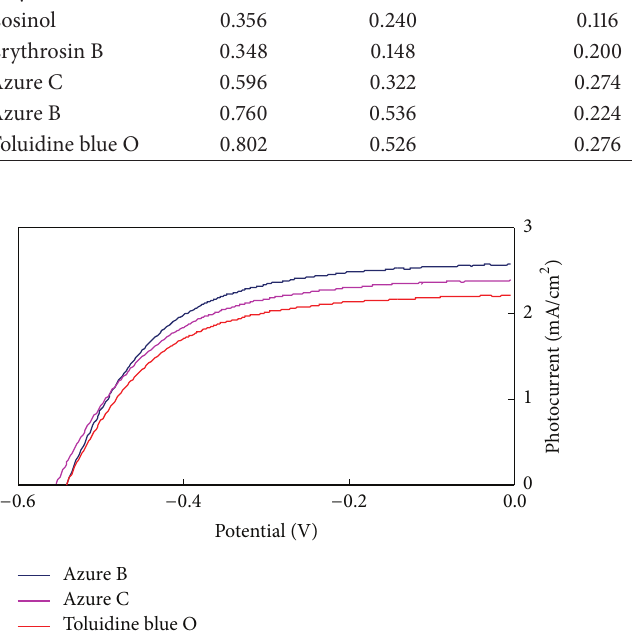
Figure 11: Action spectra of TiO 2 electrode sensitized by different thiazine based